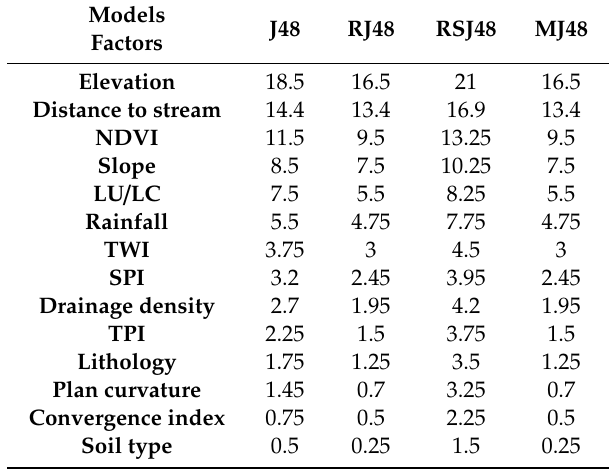
Table 5. Sensitivity analysis results from the percentage of contribution (PC) of each conditioning factor in di ff erent